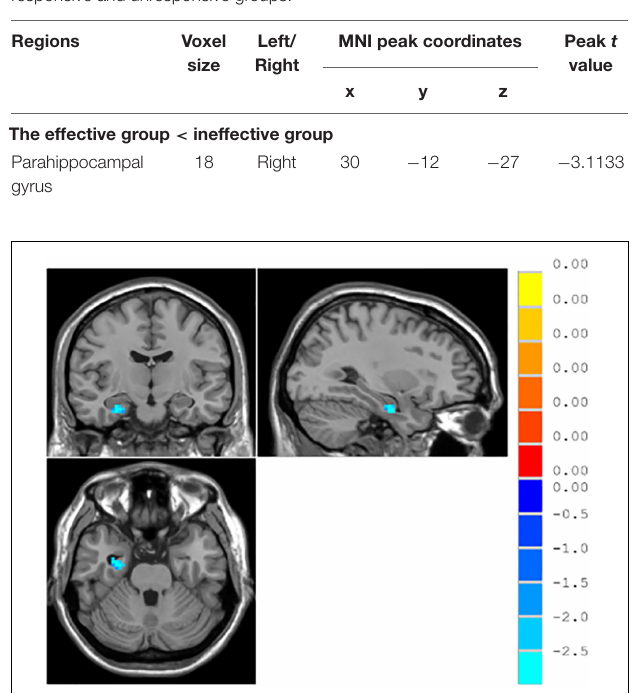
The effective group < ineffective